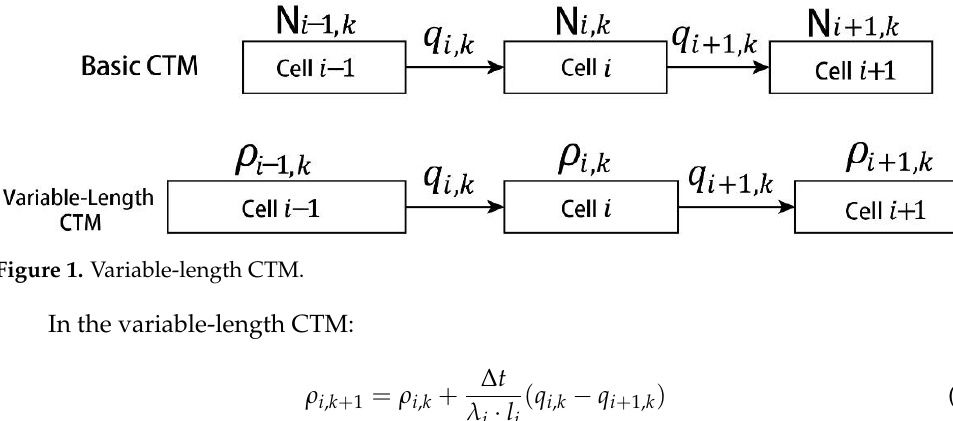
Figure 1. Variable-length CTM.